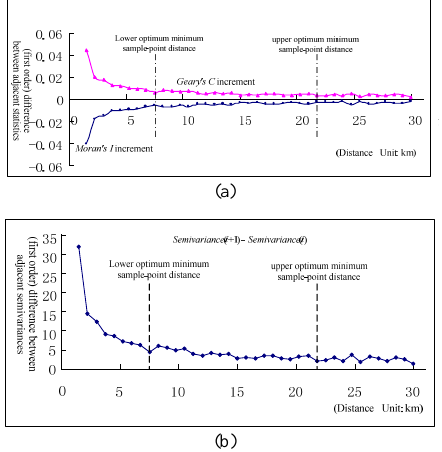
Figure 3. First order differences of (a) global spatial autocorrelation ( Moran's I , Geary's C ) and (b) semivariance with sample-point separating distances,